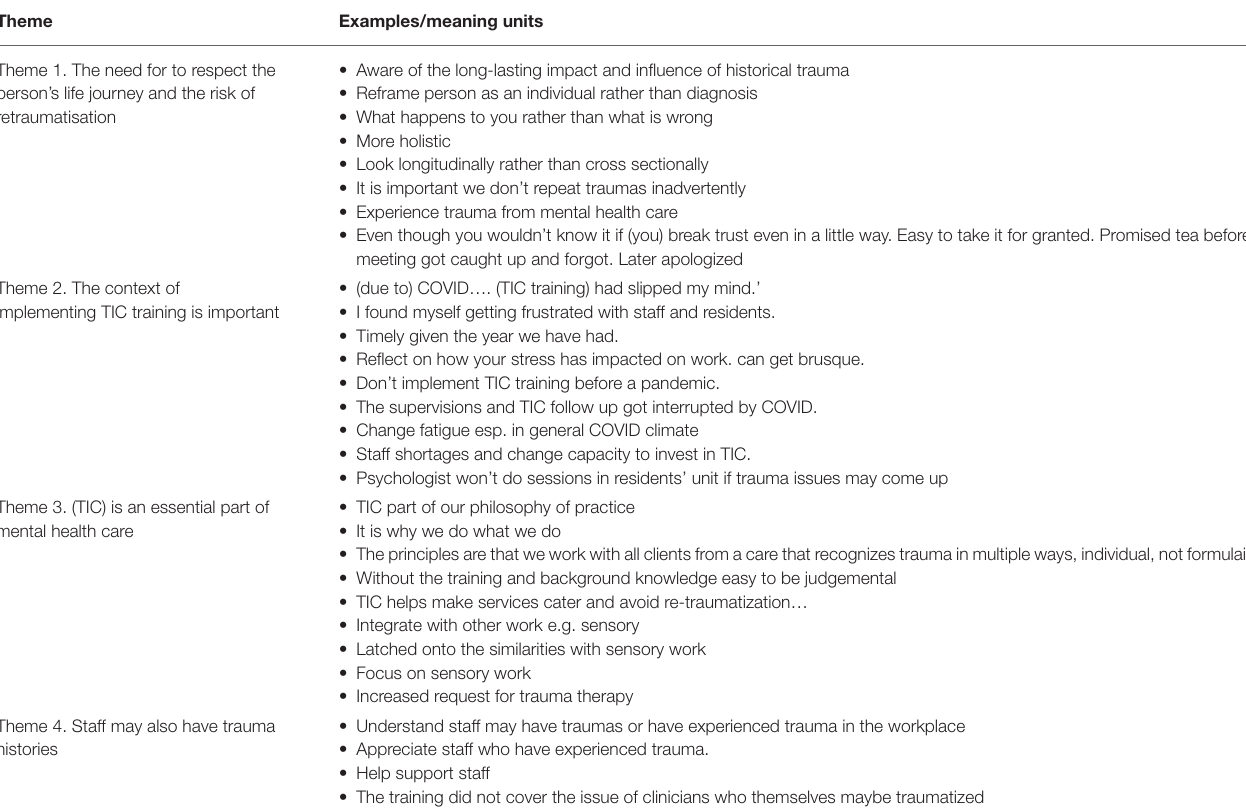
TABLE 3 | Break down of the thematic analysis of the semi structured interviews of the Team Leaders. Theme Examples/meaning